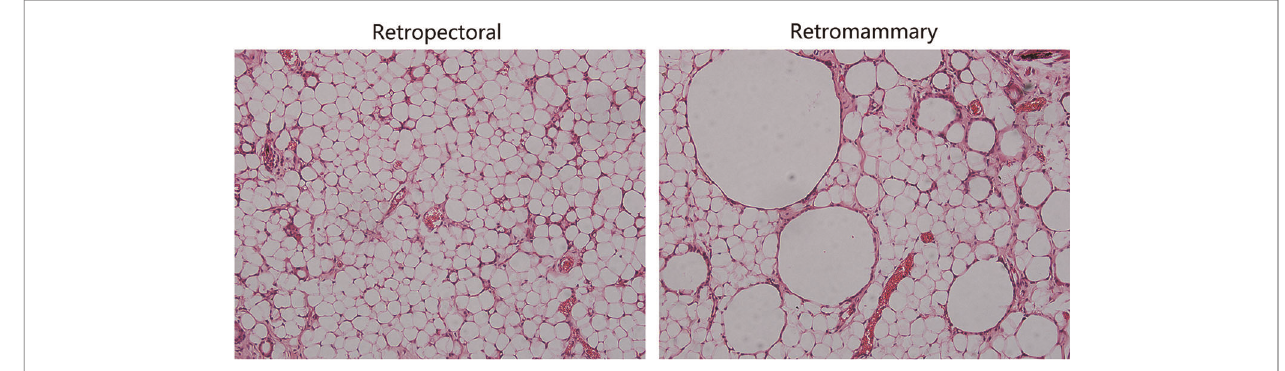
FIGURE 6 | Hematoxylin and eosin (HE) staining results of the retromammary and retropectoral fat. (Left) HE staining results of retropectoral fat tissue. The morphology of the adipocytes is uniform, and few oil cysts can be observed. (Right) HE staining results of the retromammary fat tissue. Oil cysts with different size can be observed in the surviving fat tissue.